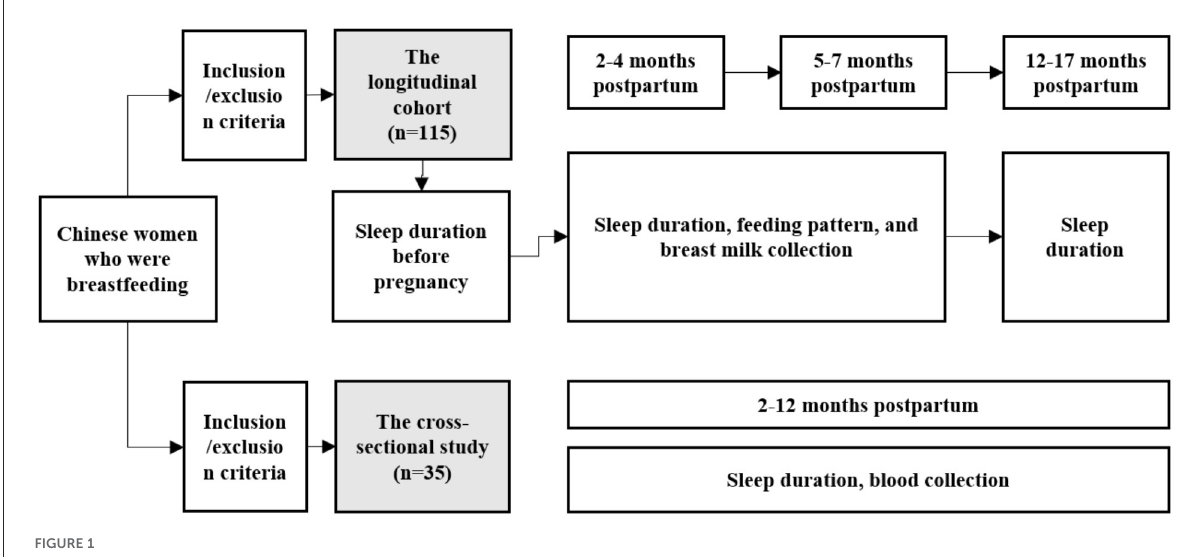
FIGURE1 Study design flow